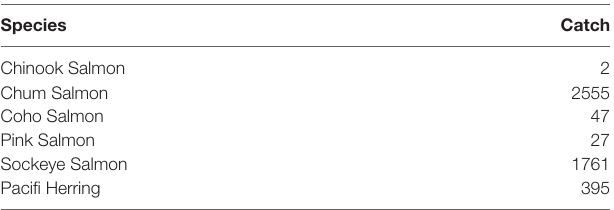
TABLE 1 | Total number of juvenile Pacific salmon and Pacific herring individuals caught by the purse seiner in Okisollo Channel.